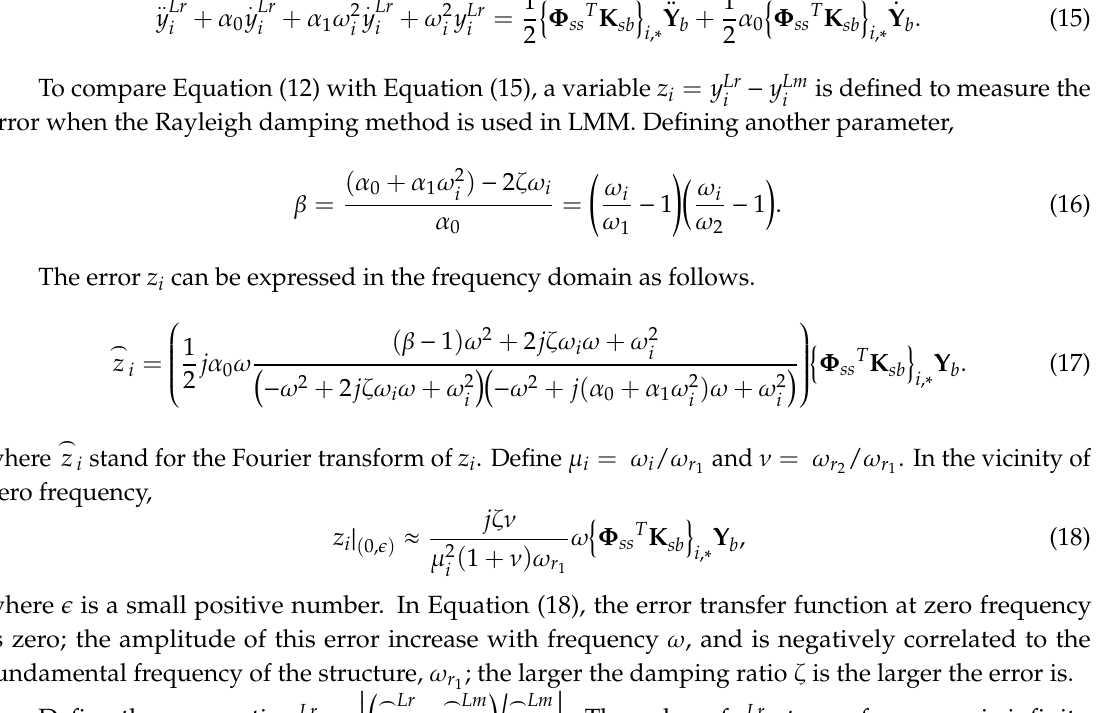
√ ω ω ( ω ) , when ω + ω r 1 r 2 / r 1 r 2